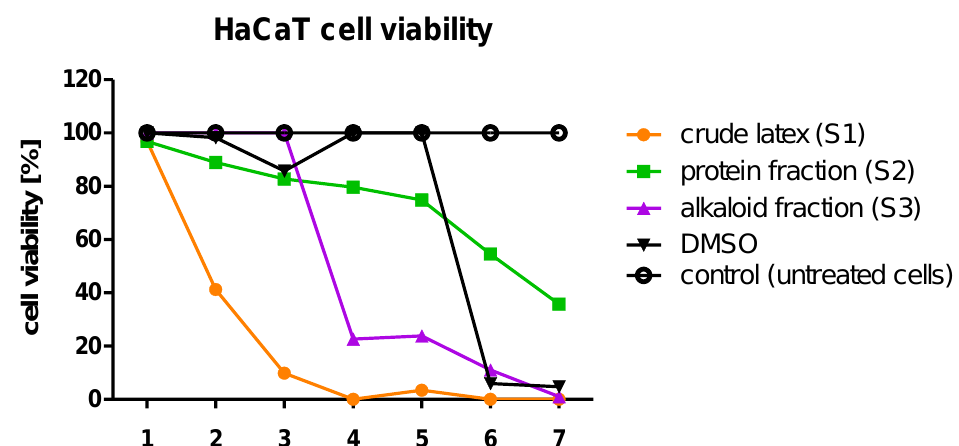
crude C. majus latex and its fractions did not degrade capsid proteins of HPV pseudoviral particles (Figure 3).